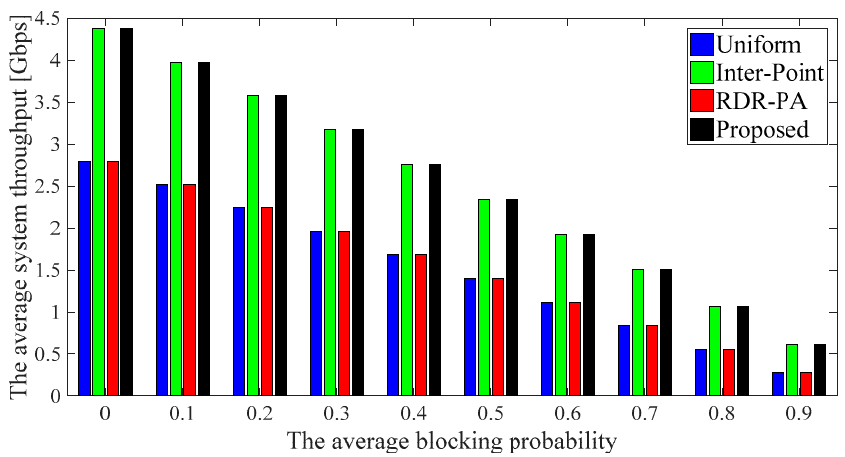
Figure 9. The average system throughput versus average blocking probability.